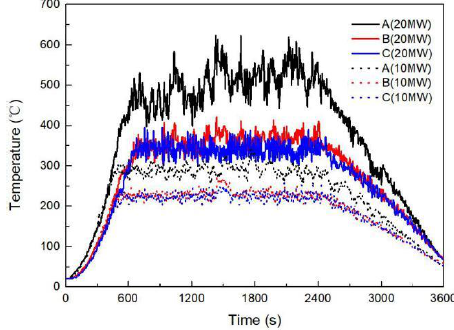
Figure 7. Air temperature at each monitoring point.